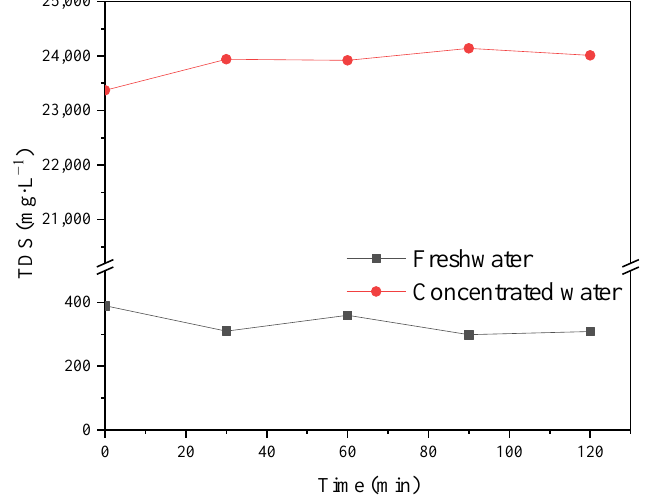
Figure 10. Effect of time on TDS.